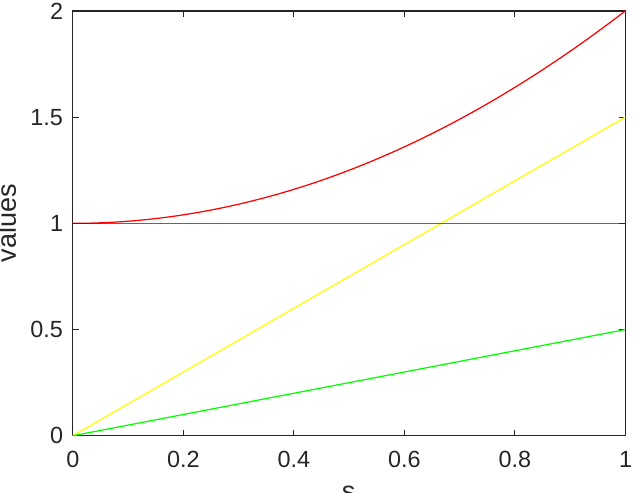
Figure 2. As shown in the above figure, 2s + s 3 as blue and s 3 as a green line, respectively. As can be seen from the graph, the Theorem 3 is valid. 3